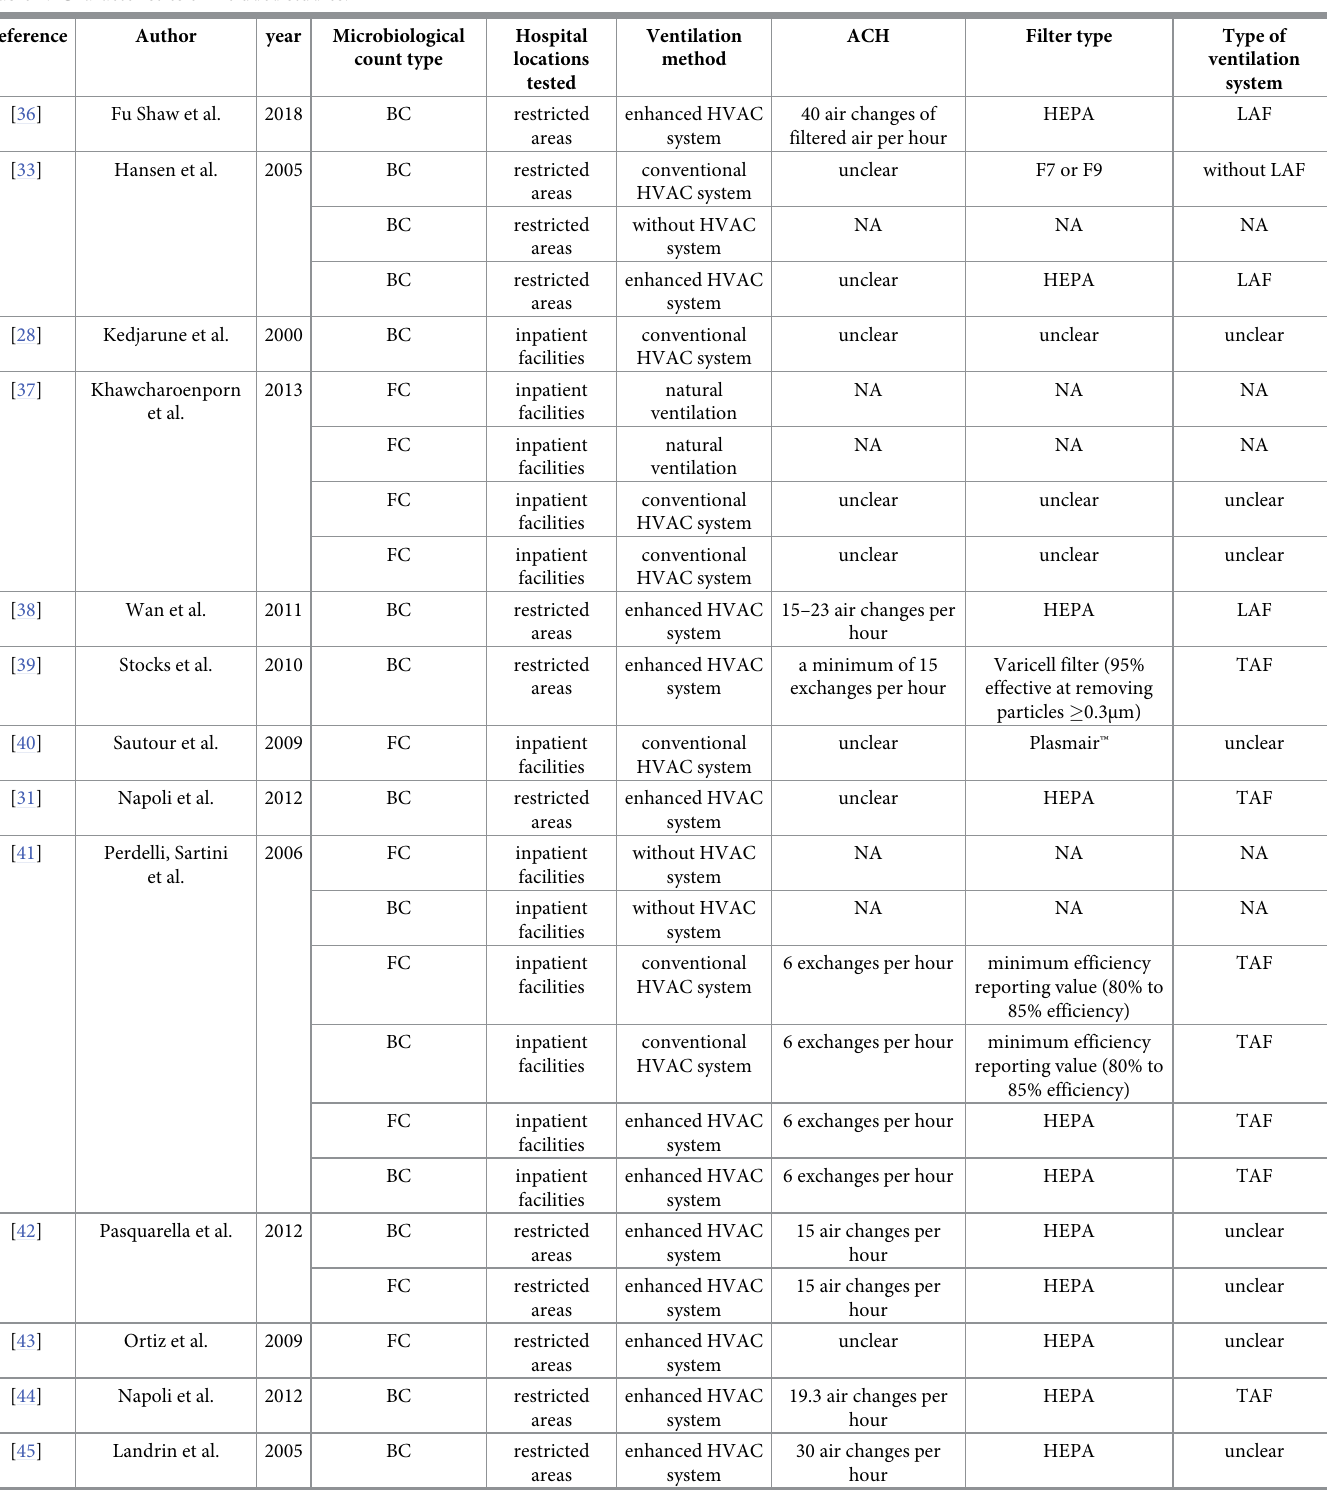
Table 1. Characteristics of included